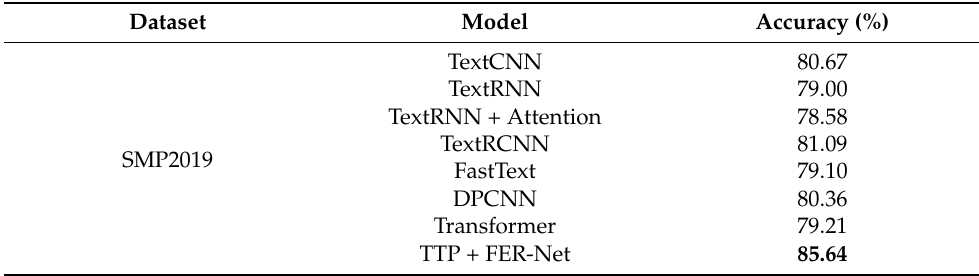
Table 3. Implicit sentiment analysis on SMP2019 dataset. (Two classifications: positive, negative).